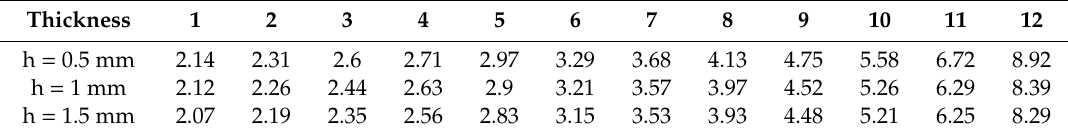
Table 2. Resonance frequency of di ff erent substrate